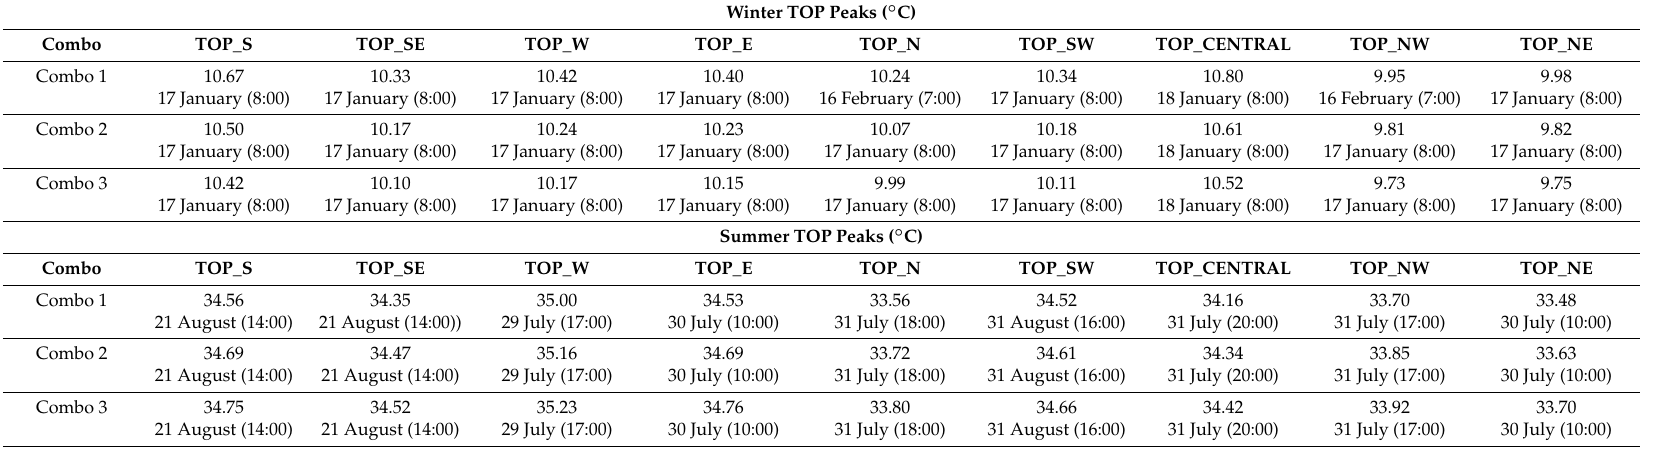
Table 8. First step: TOP yearly peaks (in bold lowest values in winter and highest values in summer). Winter TOP Peaks ( ◦